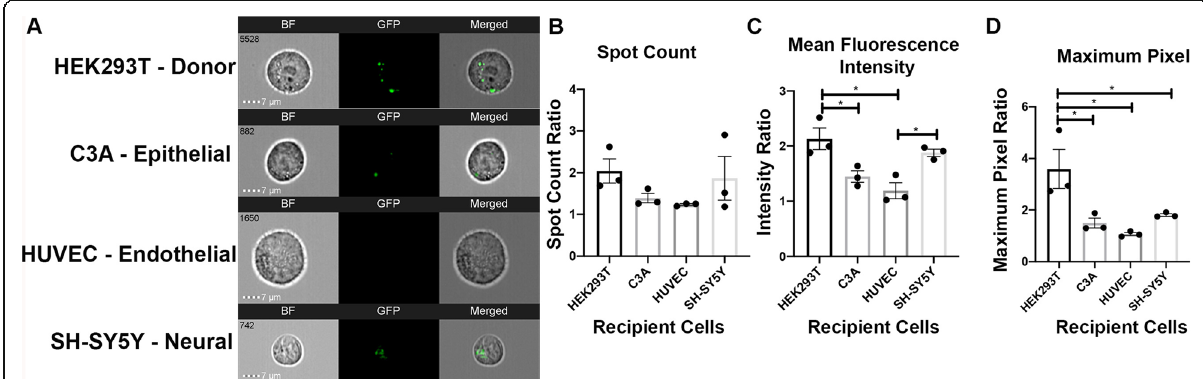
Fig. 5 HEK293T EVs display uptake preference to HEK293T cells. HEK293T EVs were co-cultured with HEK293T cells, C3A epithelial cells, human umbilical vein endothelial cells (HUVEC), and SY5Y neural cells. a Representative IFC images of recipient cells co-cultured with HEK293T EVs. b – d